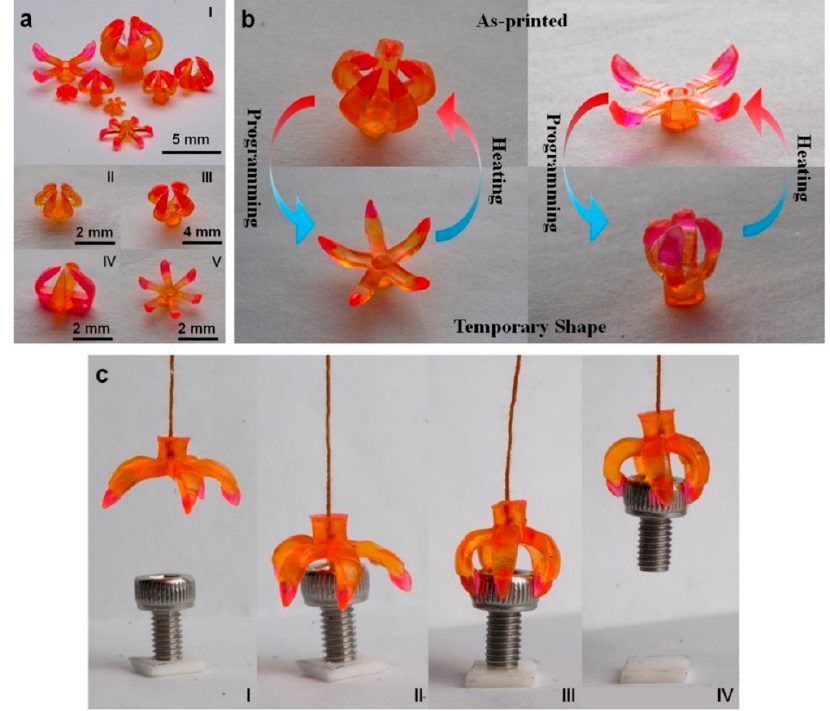
Figure 41. 3D printed multi-material grippers: ( a ) different sizes and designs of 3D printed grippers; ( b ) illustration of transitions between printed and temporary shapes as a function of temperature; ( c ) gripper used to lift a bolt assembly. Reproduced with permission from [61].